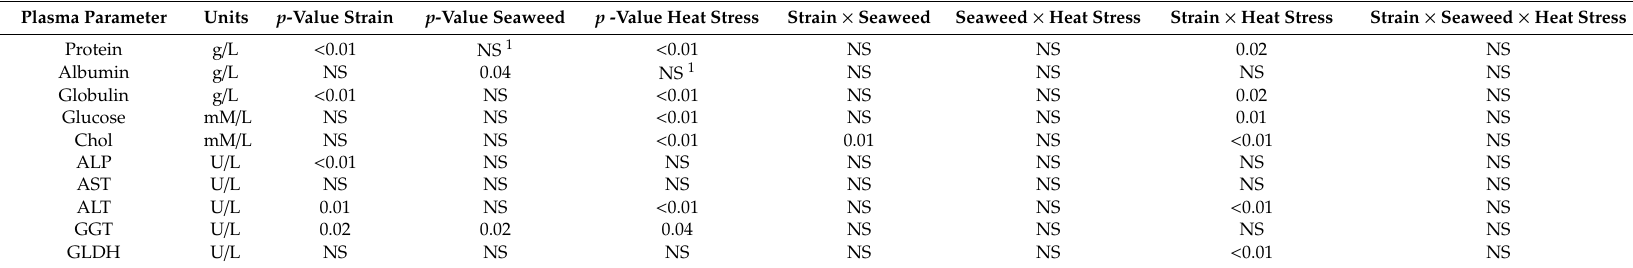
Table 4. p -Values from the ANOVA test results from the long-term trial, showing the e ff ects of the genetic strain, seaweed intake and heat stress and their interaction e ff ects on the plasma chemistry in layer